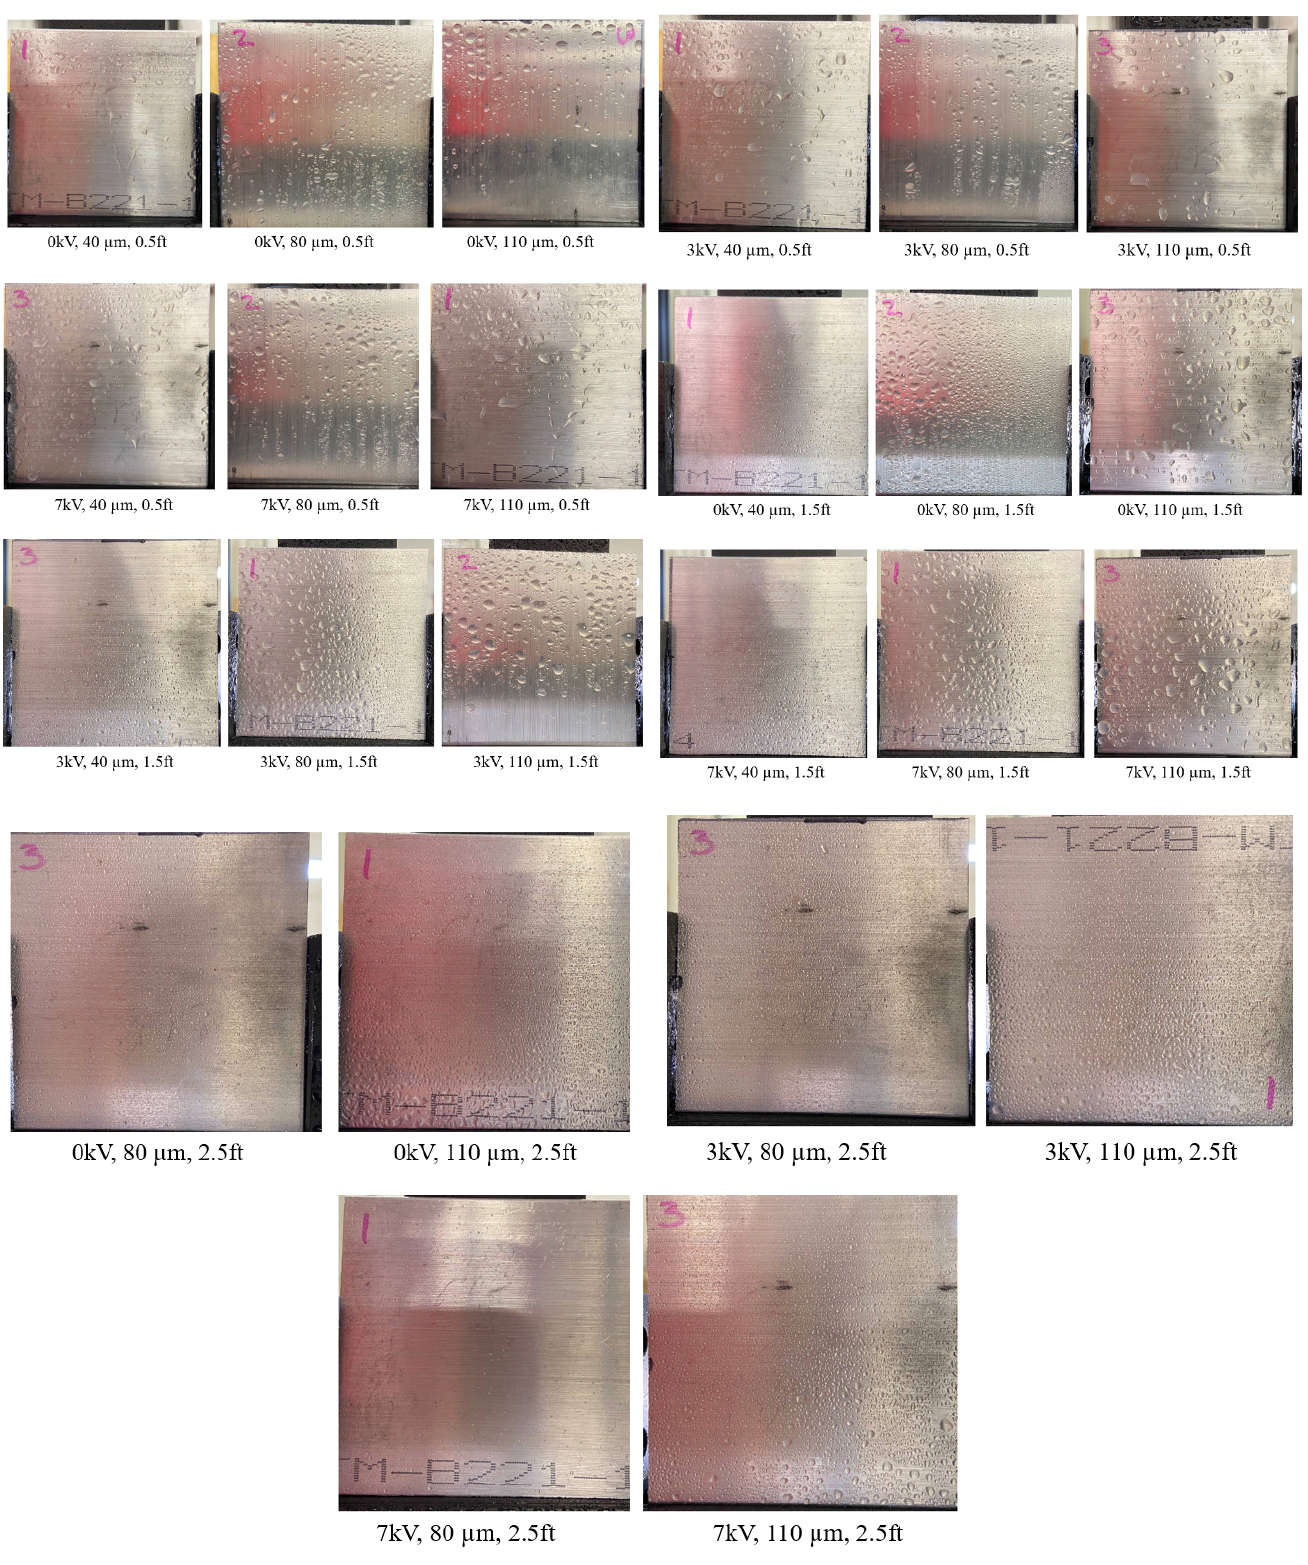
Figure A9. Aluminum: qualitative images of electrostatic deposition under various system